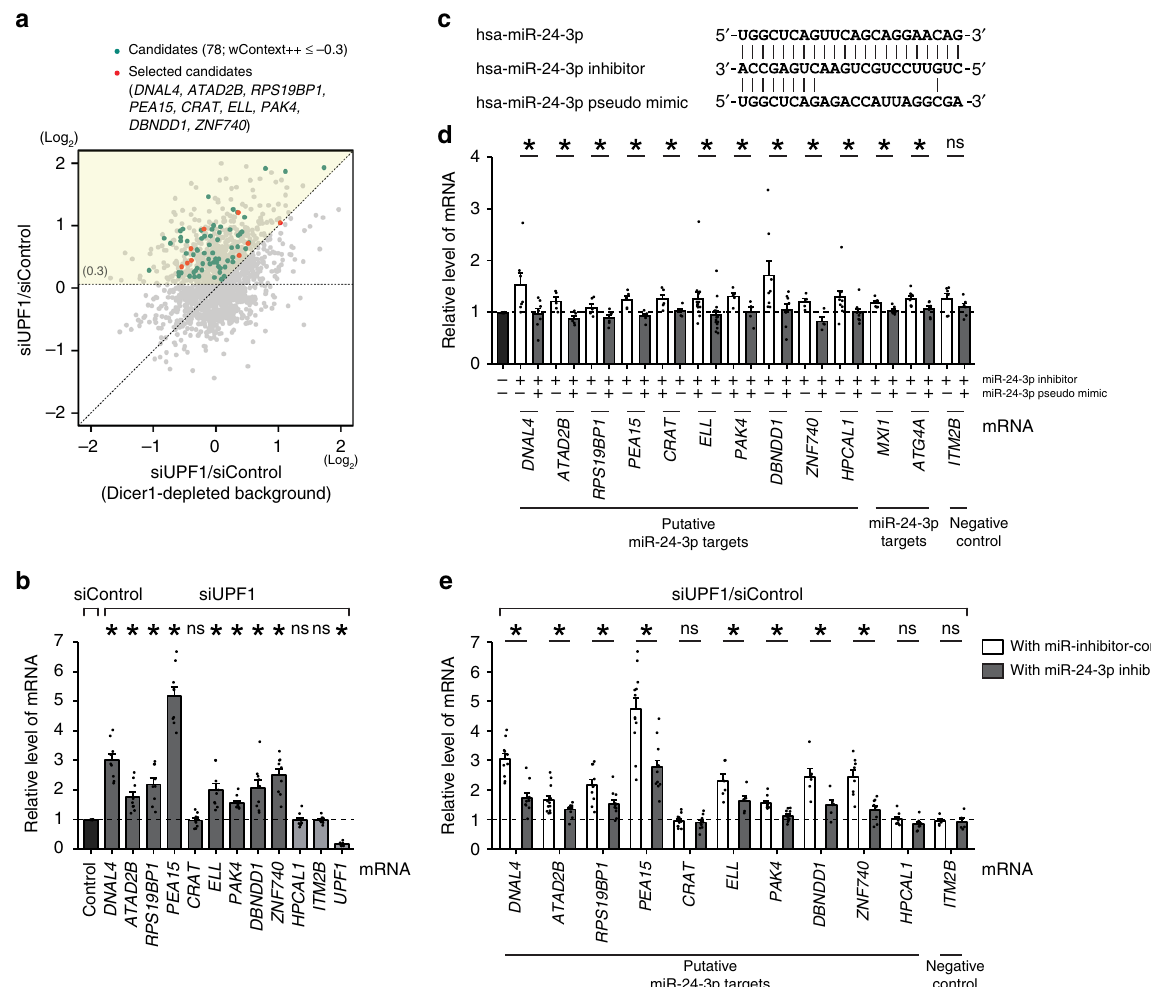
Fig. 4 Experimental validation of miRNA-dependent UMD targets. a Comparisons of changes in the expression (log 2 scale) of mRNAs with 7-mer sites in response to UPF1 depletion in siDicer1-treated and WT backgrounds. The yellow-shaded area indicates miRNA-dependent UMD targets. Candidates with a wContext + + score of less than − 0.3 were selected (green, red dots), nine of which were chosen for experimental validation (red dot). b The increased level of the selected candidates obtained from a was con fi rmed by RT-qPCR. The level of mRNA was normalized to that of GAPDH mRNA. c Sequences of human miR-24-3p, the miR-24-3p antisense inhibitor, and the miR-24-3p pseudo-mimic used in this study, where the sequence of the pseudo-mimic was identical to that of the miR-24-3p seed sequence but with different sequences beginning at the ninth nucleotide. A pseudo-mimic was used because pseudo-mimics can form base pairs with the 7-mer sites of targets but avoid inhibition by miRNA inhibitors. d HeLa cells were transfected with the inhibitor and/or pseudo-mimic, and RT-qPCR was performed to quantify the level of putative and known miR-24-3p targets. ITM2B mRNA, which does not contain any miRNA-binding sites, served as a negative control. The level of mRNA was normalized to that of GAPDH mRNA. e HeLa cells transfected with siUPF1 or siControl under miR-24-3p-depleted or control conditions. RT-qPCR was performed to quantify the level of transcripts. Mean values and s.e.m. were calculated from independent experiments. An asterisk denotes statistically signi fi cant differences ( * P < 0.05; unpaired Student ’ s t test); ns not signi fi cant. The minimum number of independent biological replicate experiments was b n = 9, d n ≥ 4, and e n ≥